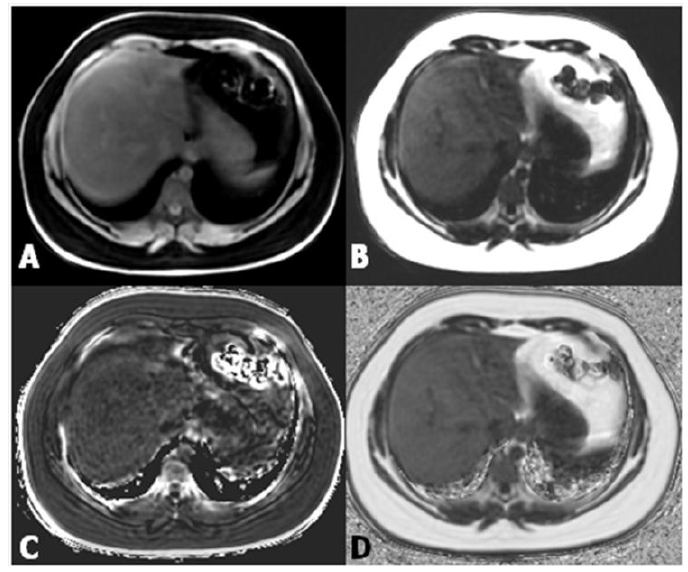
Figure 4. ( A,B ) Images from datasets acquired from a multi-echo, low flip angle sequence with clear separation of fat from nonfat tissue; ( C ) the R2 image is useful in the evaluation of iron concentration; ( D ) the fat-fraction image allows one to easily obtain the fat percentage by drawing a region of interest (ROI) within the parenchyma.